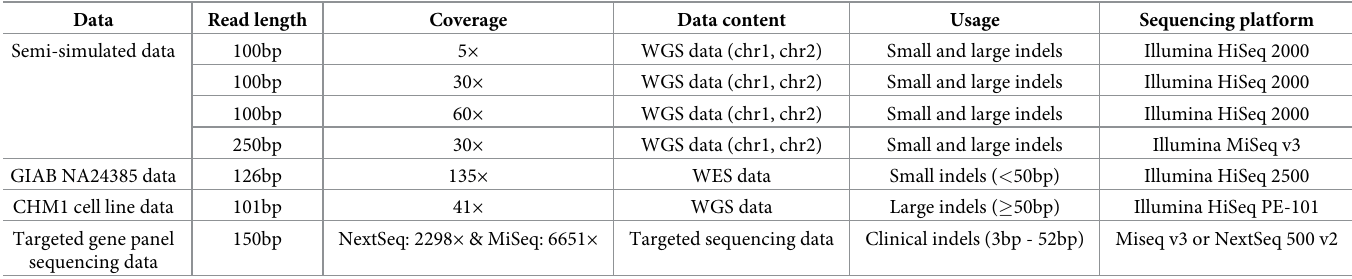
Table 2. The semi-simulated WGS sequencing and real sequencing datasets used in this